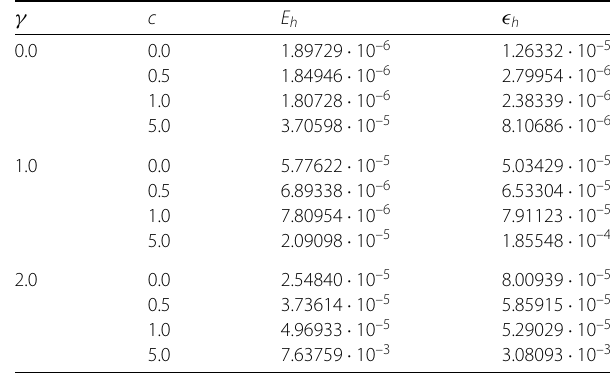
Table 4 The errors for different γ , h , and c in the case of the RHS function (50) γ c h E h (cid:10) h Order p 0.0